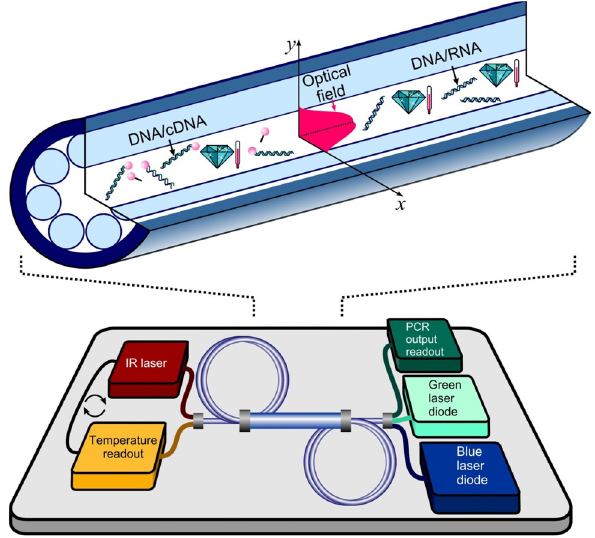
Figure 6: A photonic credit-card-size platform for rapid-cycle real- time polymerase chain reaction (qPCR) and reverse-transcription qPCR.